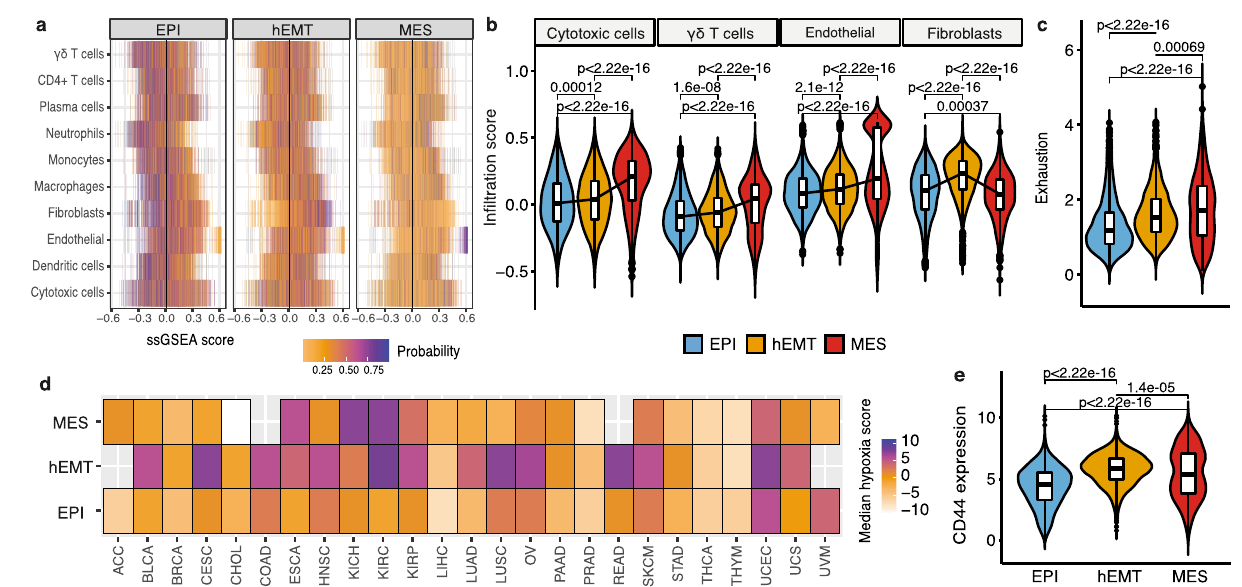
Fig.5|TumourextrinsichallmarksofEMT.a Heatmapshowcasingtheresultsof amultinomiallogisticregressionmodeltrainedtopredictEMTstatesbasedoncell in fi ltration in the microenvironment. Each row corresponds to a cell type and the corresponding per-sample in fi ltration is highlighted via single-sample Gene Set EnrichmentAnalysis(ssGSEA)scoresreportedonthe x axis.Thevaluesreportedin theheatmaparetheprobabilitiesthatasampleshouldfallintotheepithelial,hEMT or mesenchymal categories in relation to the ssGSEA score of a certain cell type. b Cell abundance compared across biologically independent samples in the epi- thelial ( n =3388), hEMT ( n =2764) and mesenchymal ( n =1028) states for selected cell types. The centerline of boxes depicts the median values; the bottom and top box edges correspond to the fi rst and third quartiles. Two-sided Wilcoxon rank- sum test p values are displayed. c Levels of exhaustion quanti fi ed across